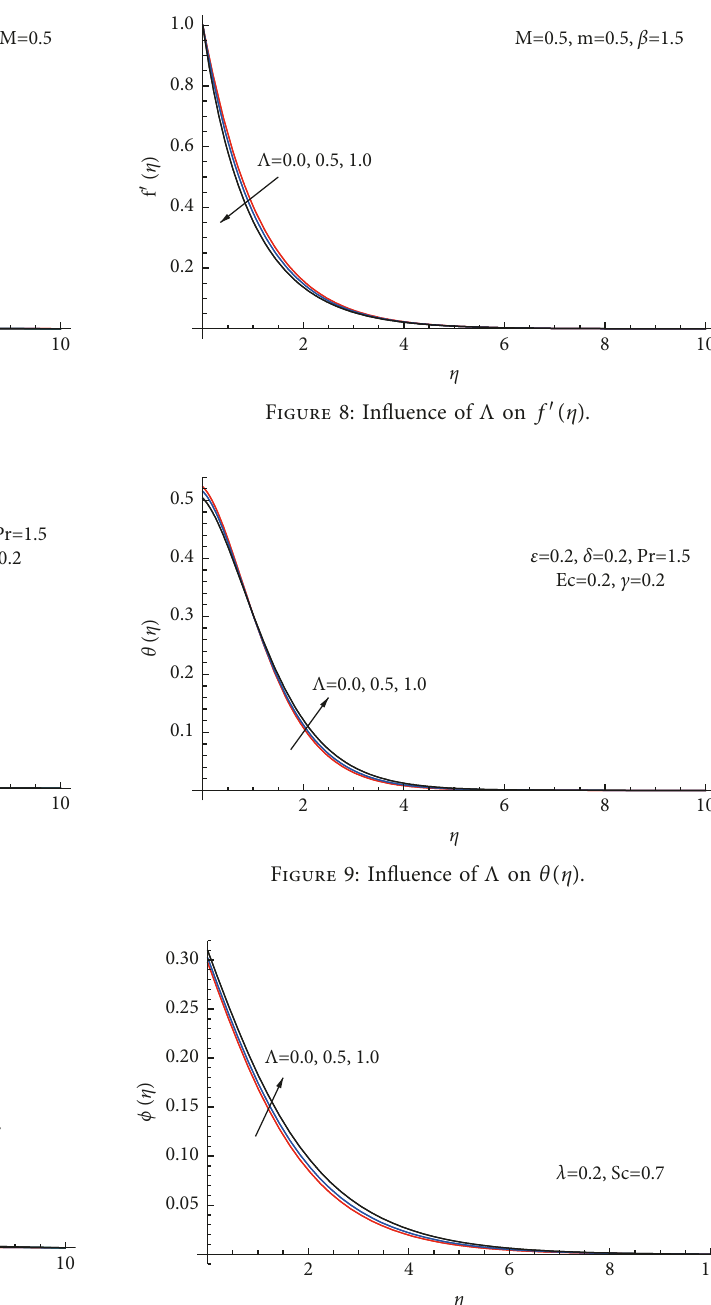
Figure 7: Influence of β on ϕ ( η ) .